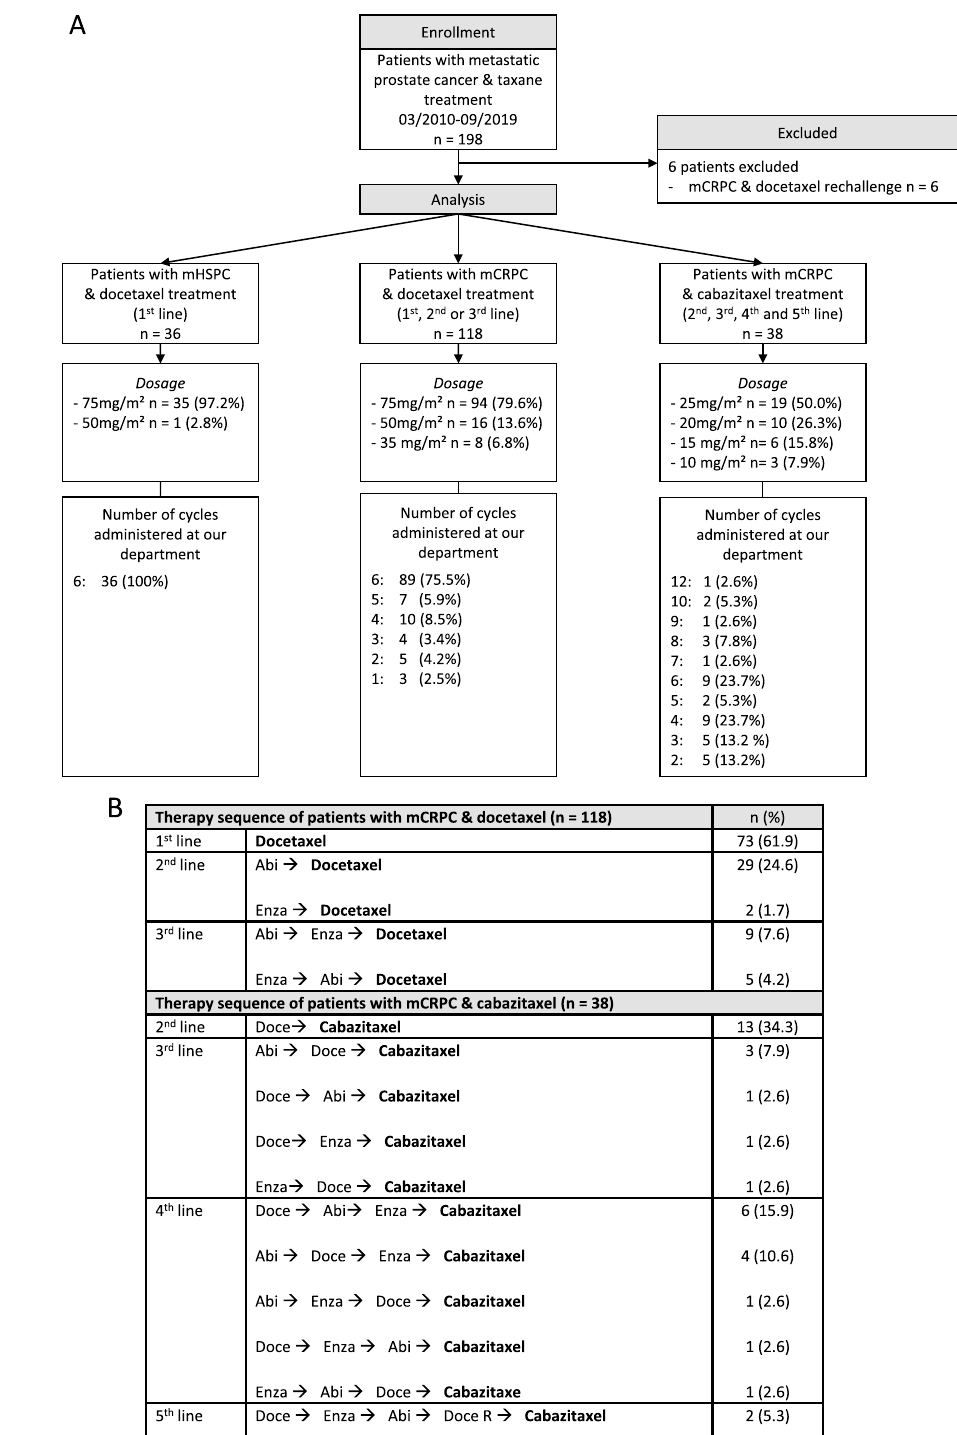
Fig. 2 Flow-diagram and treatment information of the study cohorts. mCRPC meta- static castration-refractory prostate cancer, mHSPC meta- static hormone-sensitive pros- tate cancer, Doce docetaxel, DoceR docetaxel rechallenge, Abi abiraterone acetate, Enza enzalutamide, Ra-223 Radium-